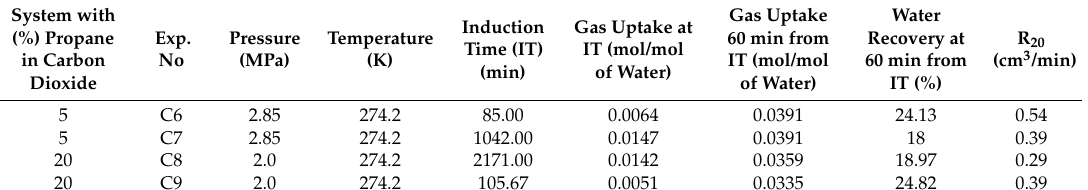
Table 3. Summary of experimental conditions and results with different concentrations of propane in carbon dioxide.